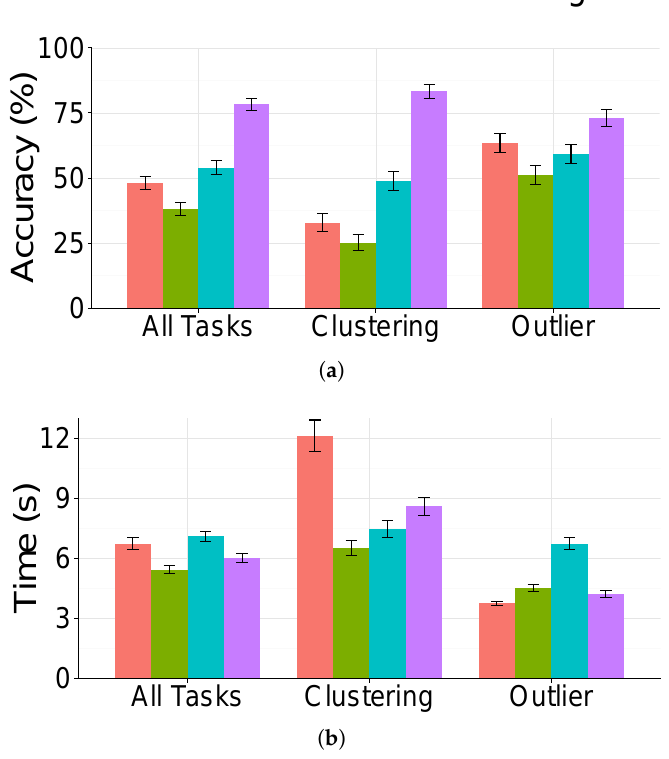
Figure 4. Mean accuracy and completion time overall and for each task. ( a ) Mean accuracy in percentage (the higher is better); ( b ) Mean completion time in seconds (the lower is better).